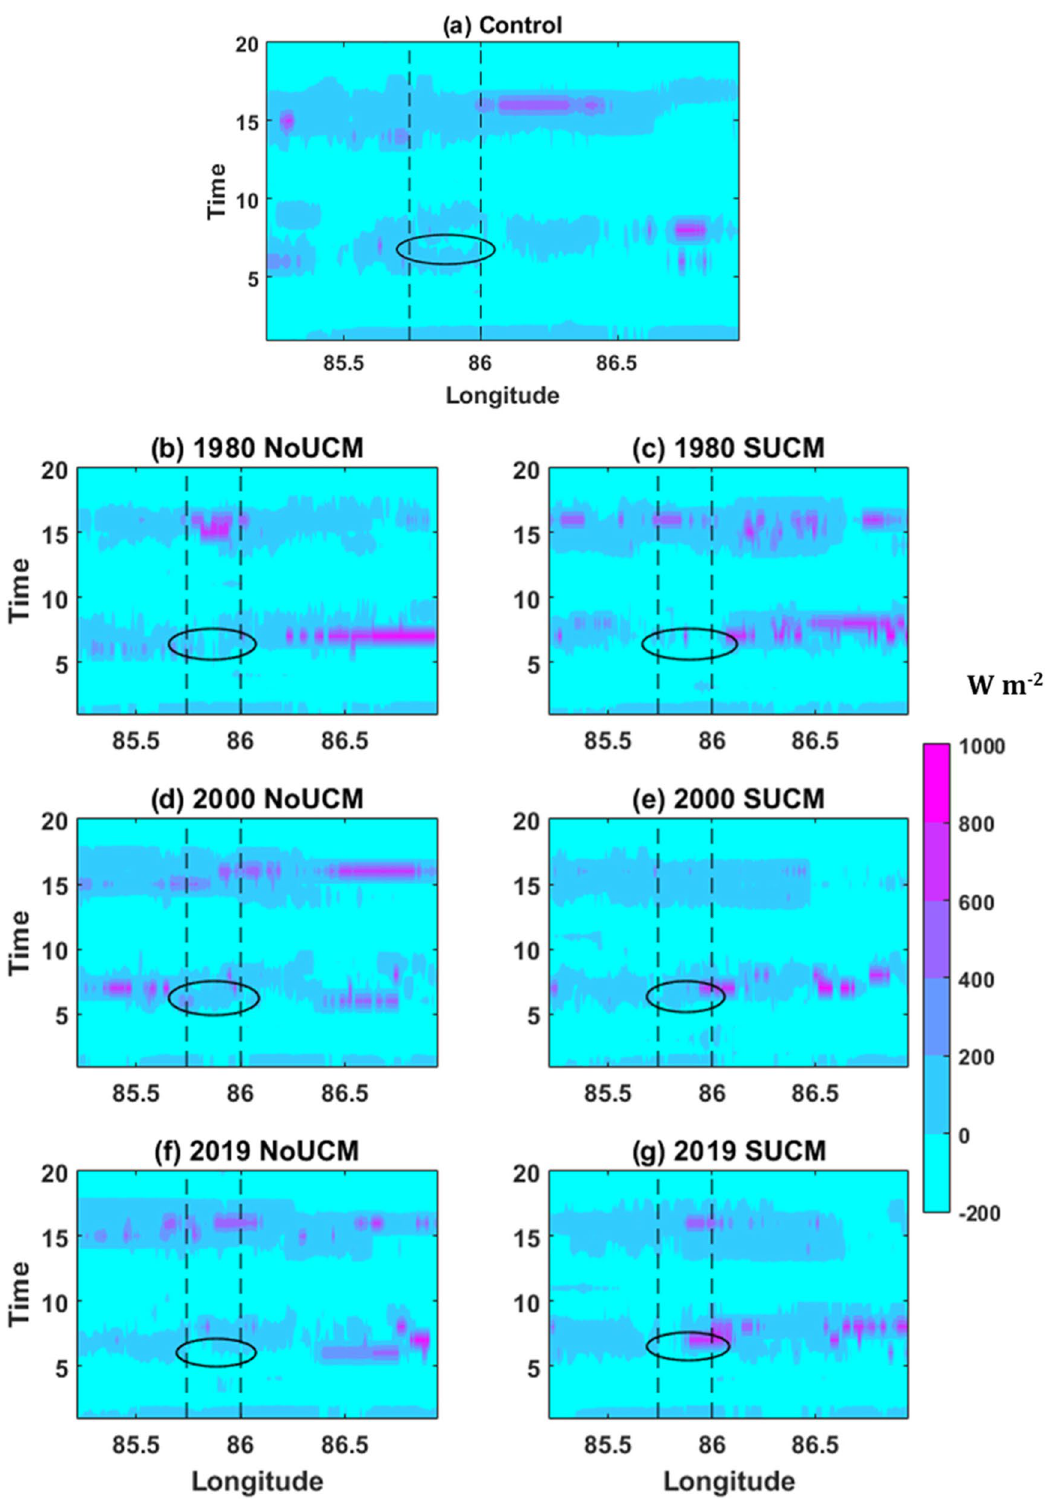
Fig. 8 Urban storage term (W m-2) for 20072018 case a control run, b 1980 NoUCM, c 1980 SUCM, d 2000 NoUCM, e 2000 SUCM, f 2019 NoUCM, and g 2019